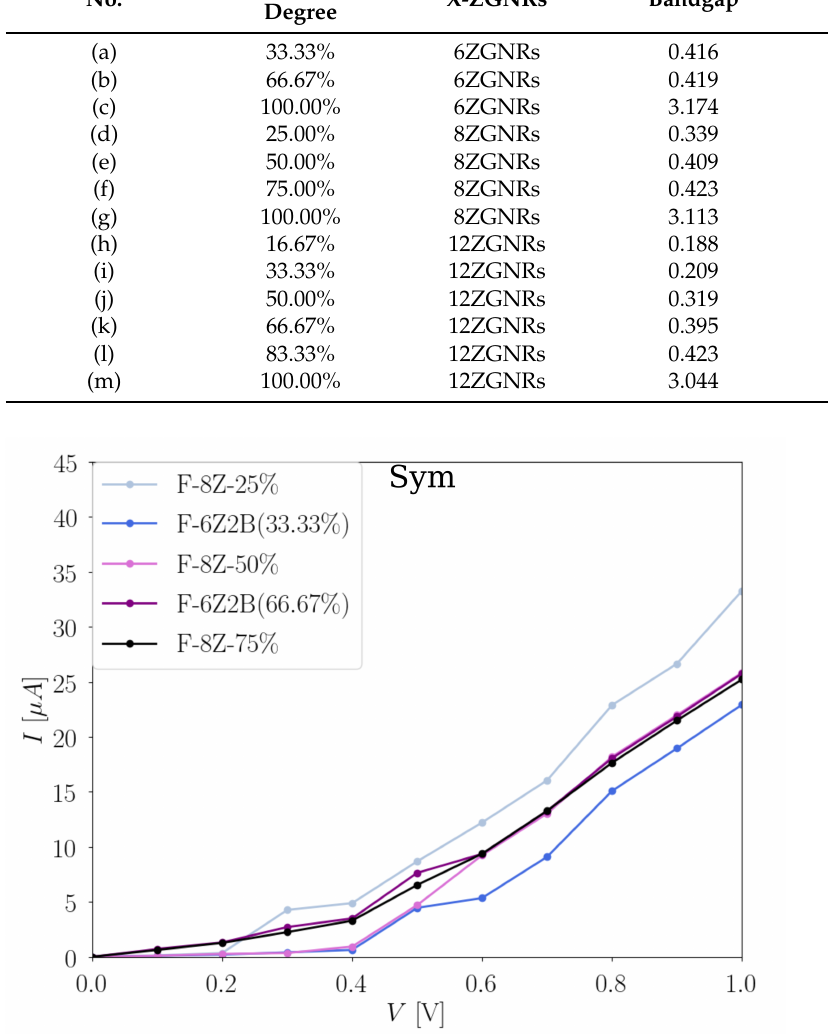
Figure 9. Total current I (µA) in dependence of the applied bias voltage V (V) with 0.1 V step for symmetric fluorinated F-6Zs and F-8Zs of both spin channels. It is noted that the values evaluated at each 0.1 V step are linearly connected for a better visualization of the evolution in the I with the increasing